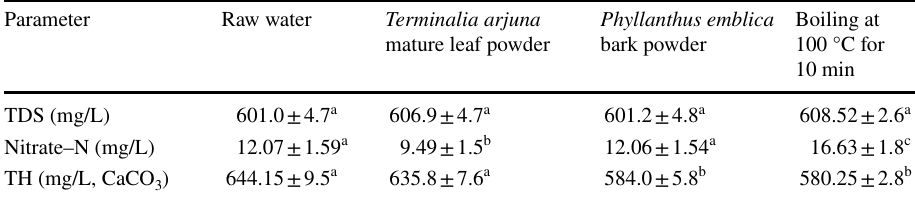
0.05)Parameter Raw The mean values indicated by different superscript letters at each row are significantly different from each other (paired t test, p <